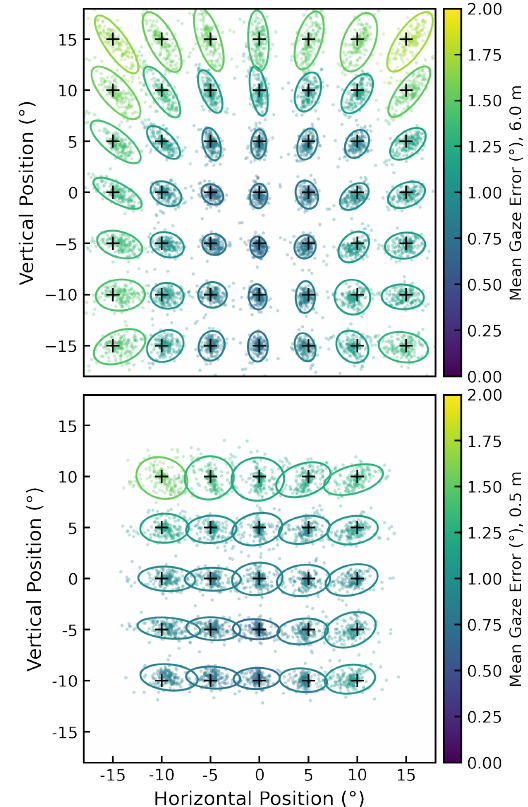
Figure 4. Average gaze position and 95% confidence ellipses for each target position, shown separately for the 6 m (top) and 0.5 m depth plane (bottom). Color scale illustrates average gaze accuracy in degrees across all trials presenting the correspond- ing target. Black crosses indicate target positions (cross arms approximate